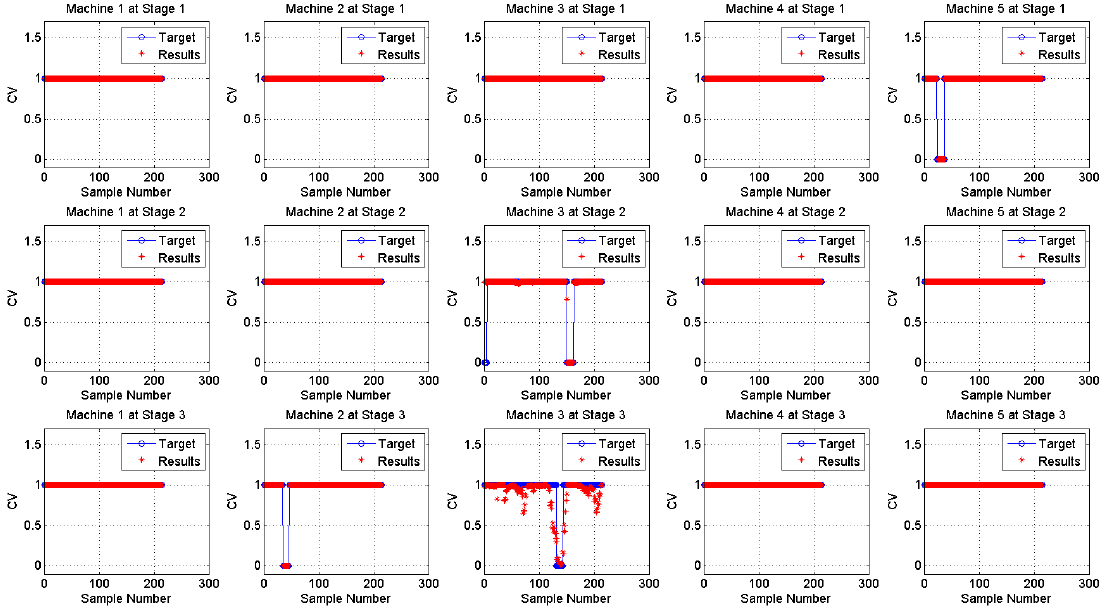
Figure 11. The results of the BN for monitoring and diagnosis of a multistage manufacturing process with three stages and five machines per stage.